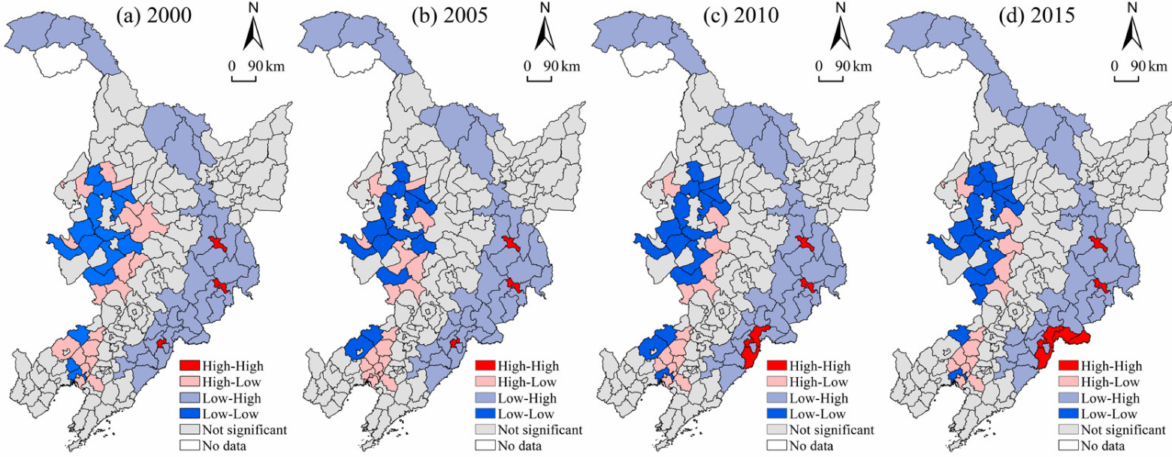
Figure 8. Spatial corresponding patterns of bivariate spatial autocorrelation between TSDI and HQ for the years ( a ) 2000; ( b ) 2005; ( c ) 2010; ( d )